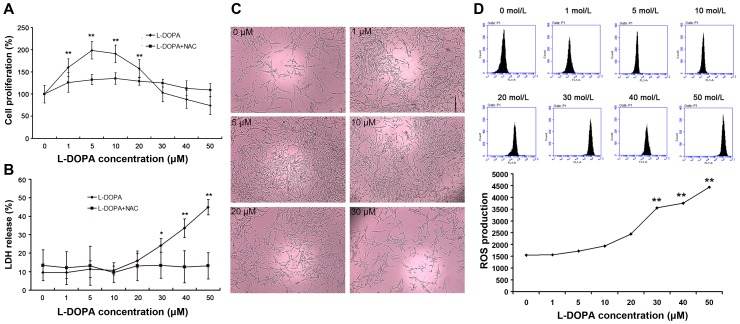
Effect of L-DOPA at different concentrations on proliferation of PC12 cells with or without ROS scavenger (χ±σ, n = 10).PC12 cells were treated with 0, 1, 5, 10, 20, 30, 40 and 50 µmol/L L-DOPA for 3 days with or without NAC (as ROS scavenger) pretreatment. The cell proliferation and growth were detected by MTT assay and LDH assay and cells were also observed under an optical microscope. The OD in treated groups was compared with that of untreated group. (A) The cell proliferation with or without NAC pretreatment was detected by MTT. Results showed L-DOPA at lower than 30 µM promoted the proliferation of PC12 cells, while proliferation remained unchanged when L-DOPA was greater than 30 µM. This promoted proliferation was compromised by NAC. (B) The cell growth was detected by LDH assay. Results showed that the LDH content in 1, 5, 10 and 20 µM groups was lower than that in 30, 40 and 50 µM groups, meaning that cells had better growth in lower L-DOPA concentration groups. NAC could also eliminate this influence. (C) The growth of PC12 cells without NAC pretreatment was observed under an optical microscope (×100). PC12 cells had a higher intensity after treatment with L-DOPA at 1, 5, 10 and 20 µM, while the number of PC12 cells reduced in 30, 40 and 50 µM groups. (D) Intracellular ROS level was measured in each group. The higher the L-DOPA concentration, the higher the ROS level was. *P<0.01, **P<0.05 vs. 0 µmol/L L-DOPA group.